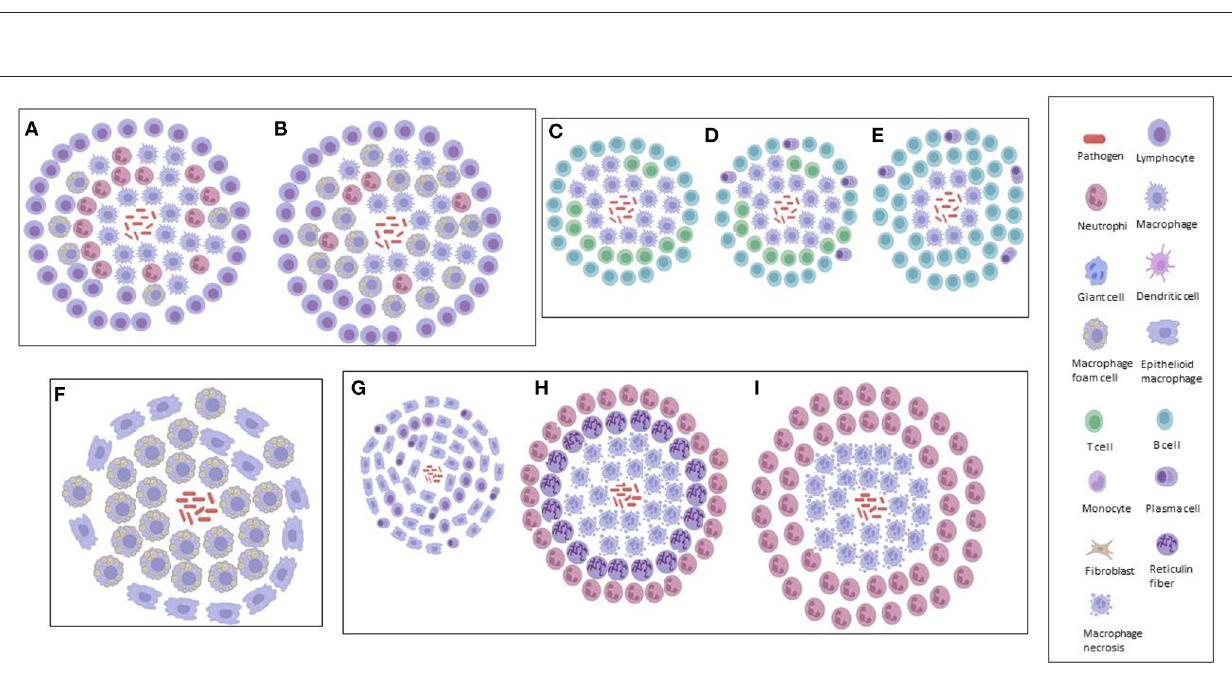
FIGURE 2 | Graphical illustrations of TB granulomas based upon key cellular elements in their categorizations, based upon literature. (A) Primary granuloma. (B) Secondary granuloma. (C) Type 1 granuloma. (D) Type II granuloma. (E) Type III granuloma. (F) Early granuloma. (G) Non-necrotizing granuloma. (H) Necrotizing gummatous granuloma. (I) Necrotizing abscess